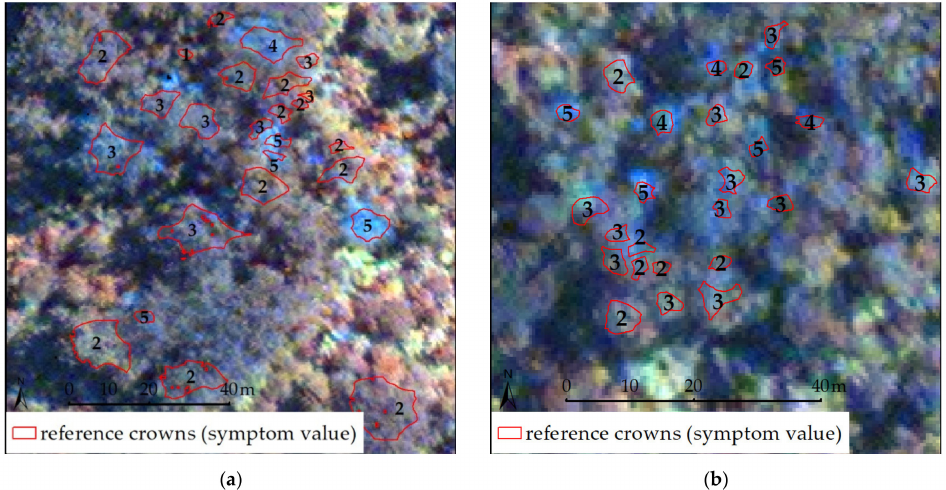
Figure 5. Reference crowns in a high kauri stand ( a ) and a low stand ( b ), with symptom values from 1 = non-symptomatic to 5 = dead, on a NIR1 green-blue composite of the WorldView-2 (WV2) image.